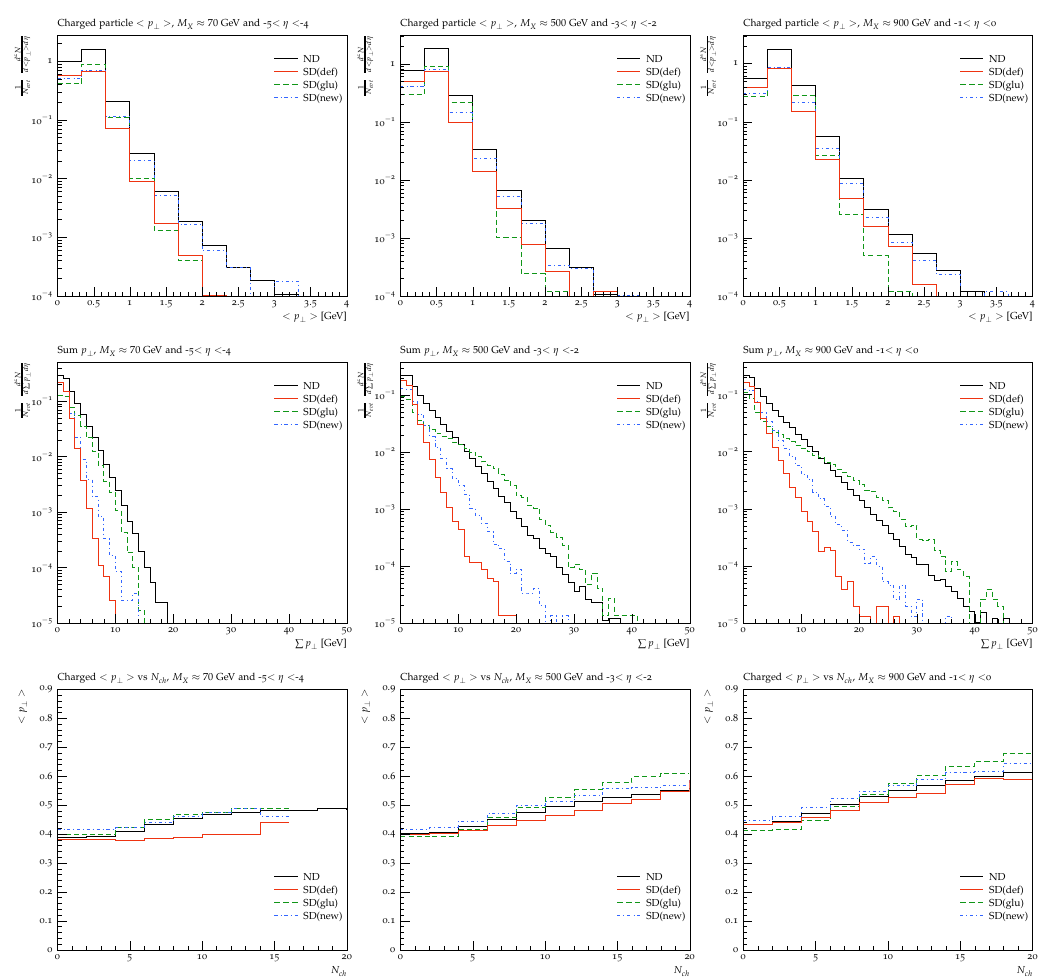
Figure 8 . As (cid:12)gure 7, but di(cid:11)erent observables. The top panel shows the average transverse momentum, while the middle one shows the summed transverse momentum and the bottom panel the average transverse momentum as a function of the